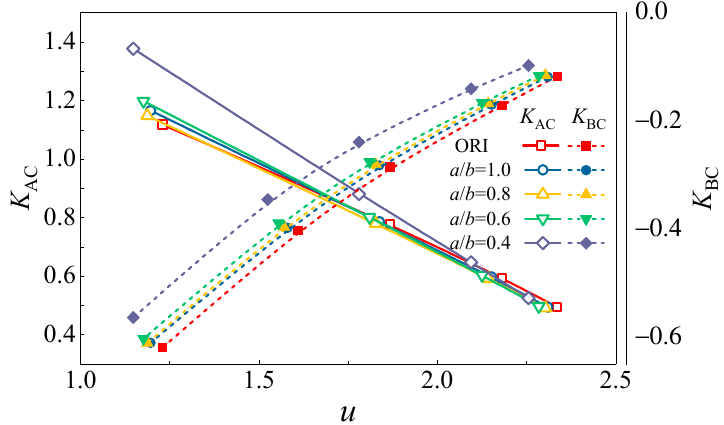
Figure 13. The distribution of injection flow loss with the variation in injection ratio.